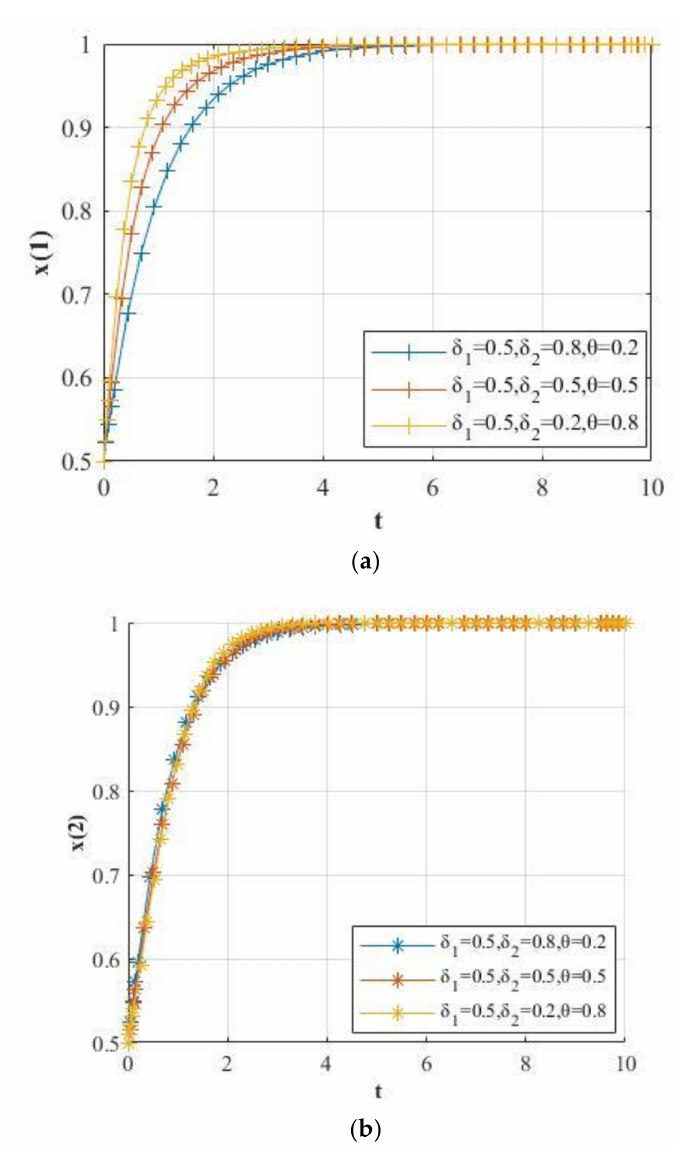
Figure 12. ( a ) While changing δ 2 , θ , and δ 1 = 0.5, evolution diagram of government’s supervision option. ( b ) While changing δ 2 , θ , and δ 1 = 0.5, evolution diagram of platform’s supervision